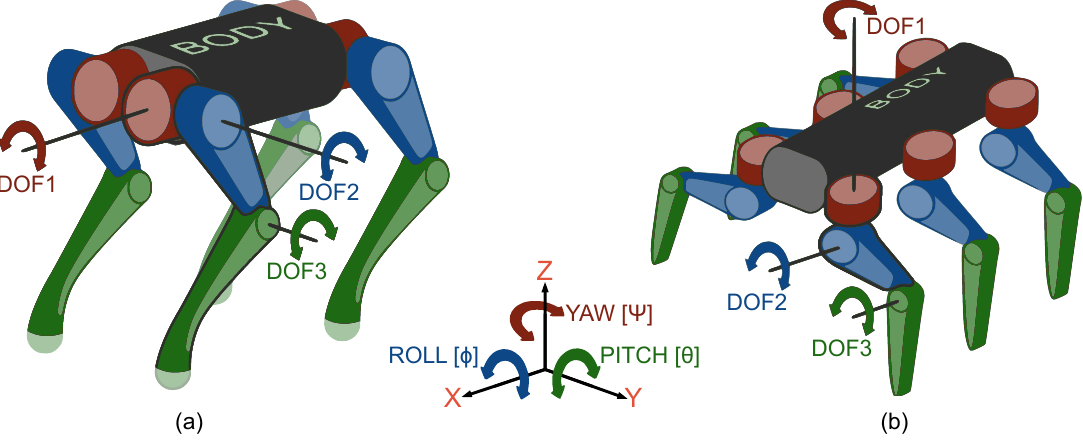
Figure 1. Illustration of ( a ) 4-legged and ( b ) 6-legged 3-degrees-of-freedoms (DOF) template morphologies for walking robots. On each drawing the segments and motors for the degrees-of-freedoms (DOF) are colour coded, where red indicates DOF1, blue DOF2 and green